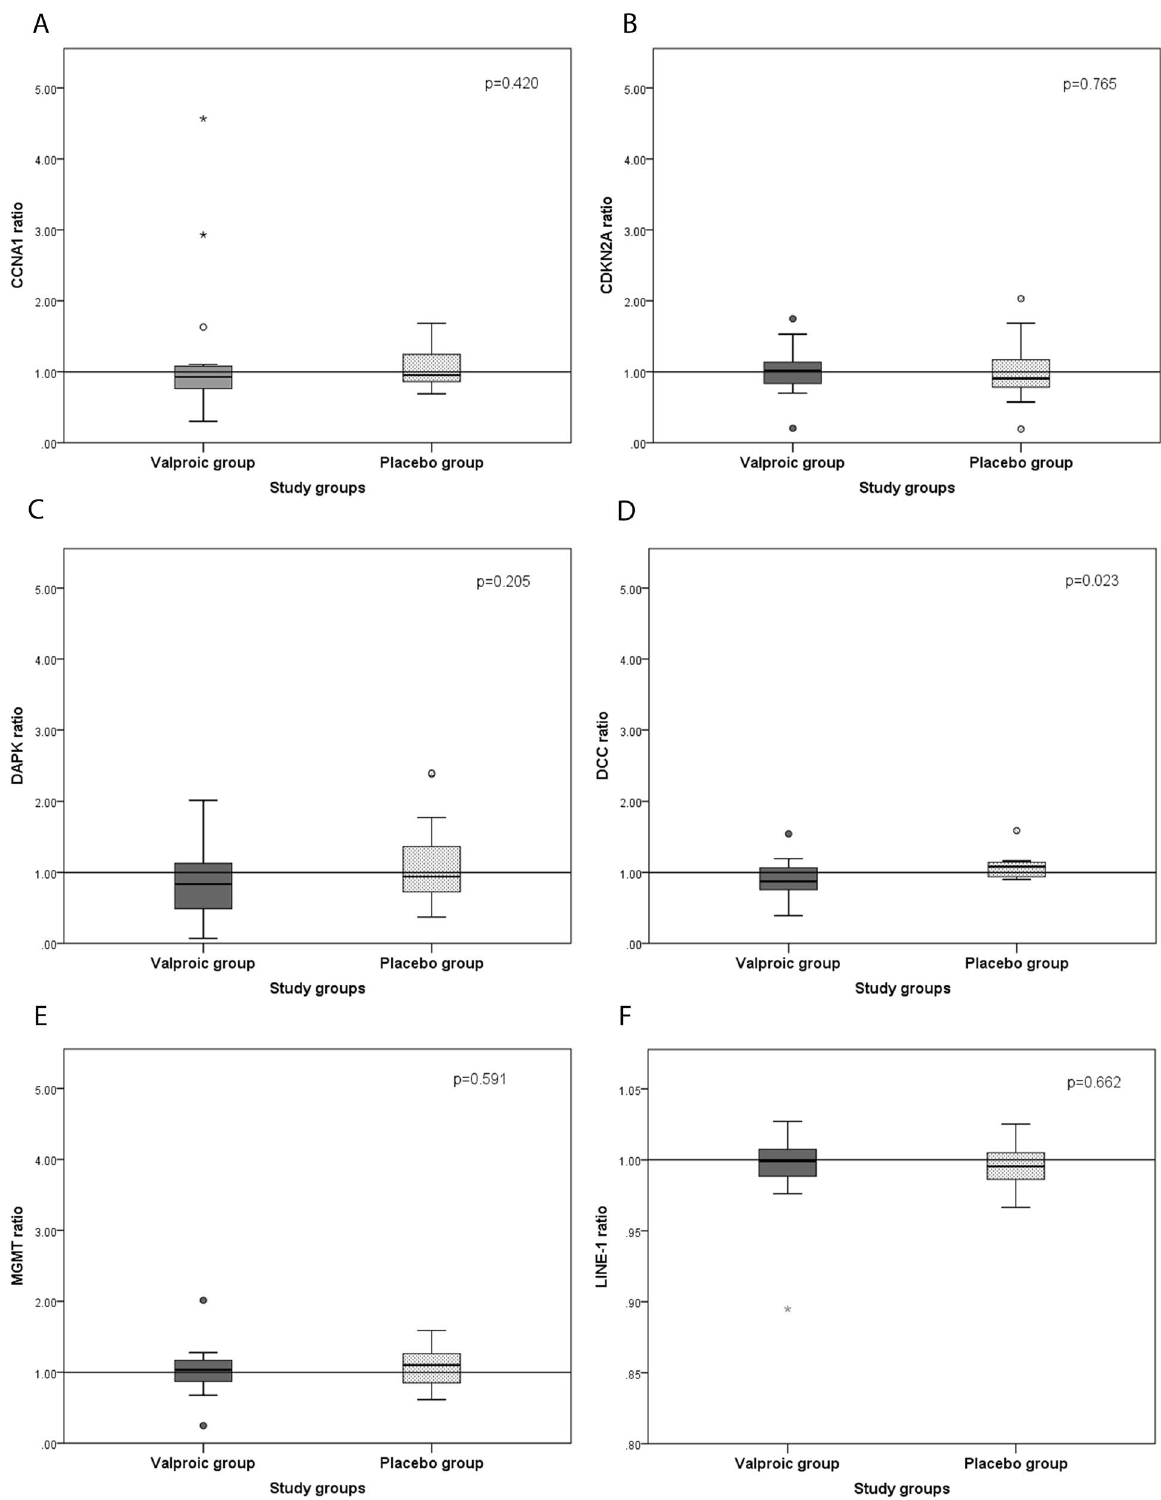
Figure 2. Comparison between the medians of the T1/T0 methylation ratios of CCNA1 ( A ), CDKN2A ( B ), DAPK ( C ), DCC ( D ), MGMT ( E ), and LINE-1 ( F ) in oral rinse samples between the valproic and placebo groups. The boxplots show the median, maximum and minimum values, interquartile range and outliers (represented by circles and stars) in the two study groups. The dashed line passing through 1 indicates that the group participants located above the line demonstrated